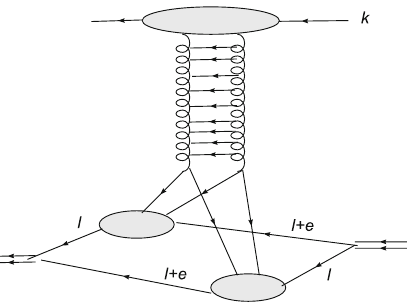
Fig. 9 The amplitude with the reggeized piece D R